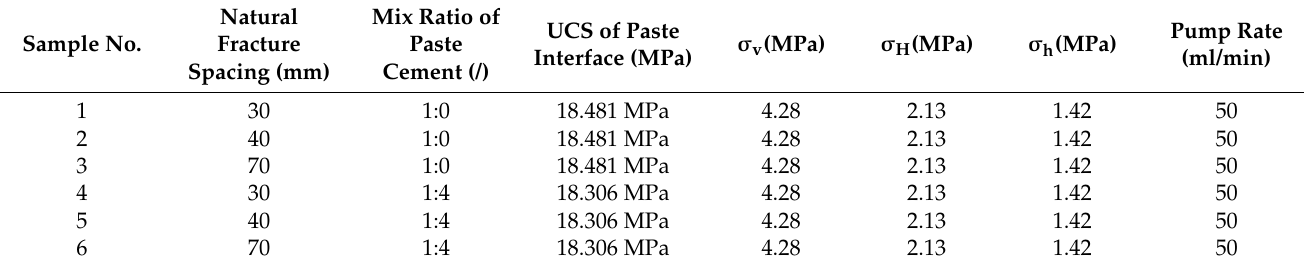
Figure 5. The triaxial hydraulic fracturing test system used in this work. Table 3. Testing conditions in this work for model blocks with different natural fracture